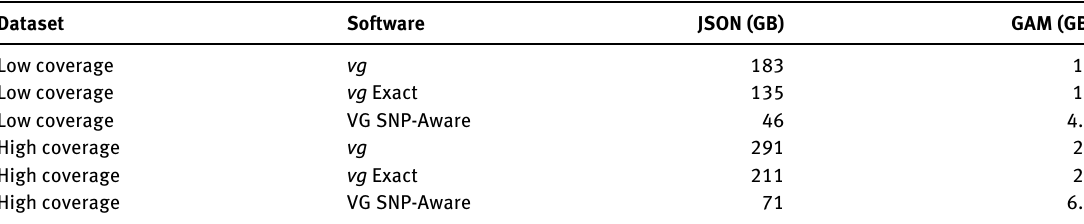
Table 3: Size of the output alignment file for all datasets and tools.